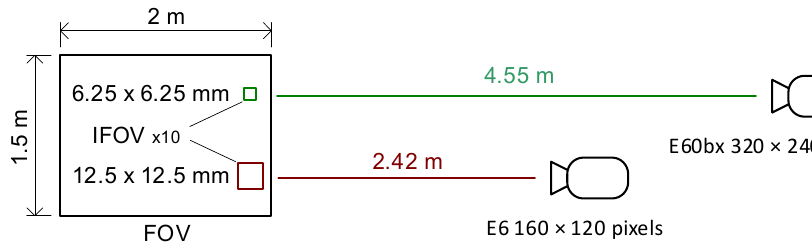
Figure 5. FOV and IFOV of the available Flir E6 and Flir E60bx cameras.